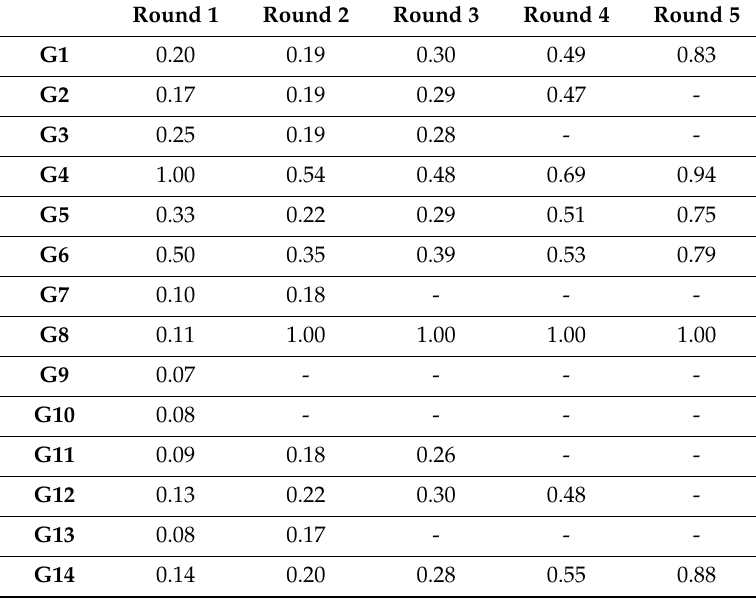
Table 4. Results of feature importance ranking. Values are given as relative importance values (ratio to best achieved for any feature group in all test runs of the respective step).